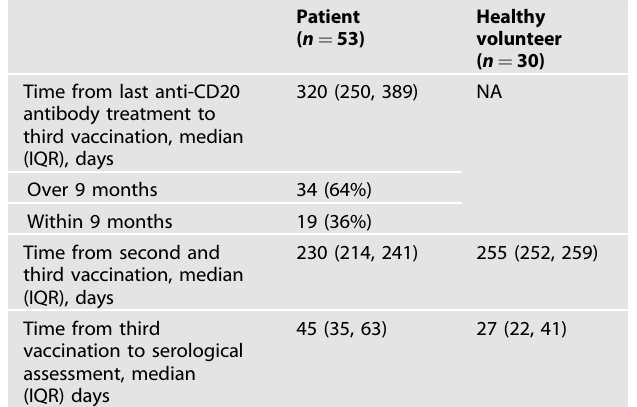
Table 1. Characteristics of patients and healthy